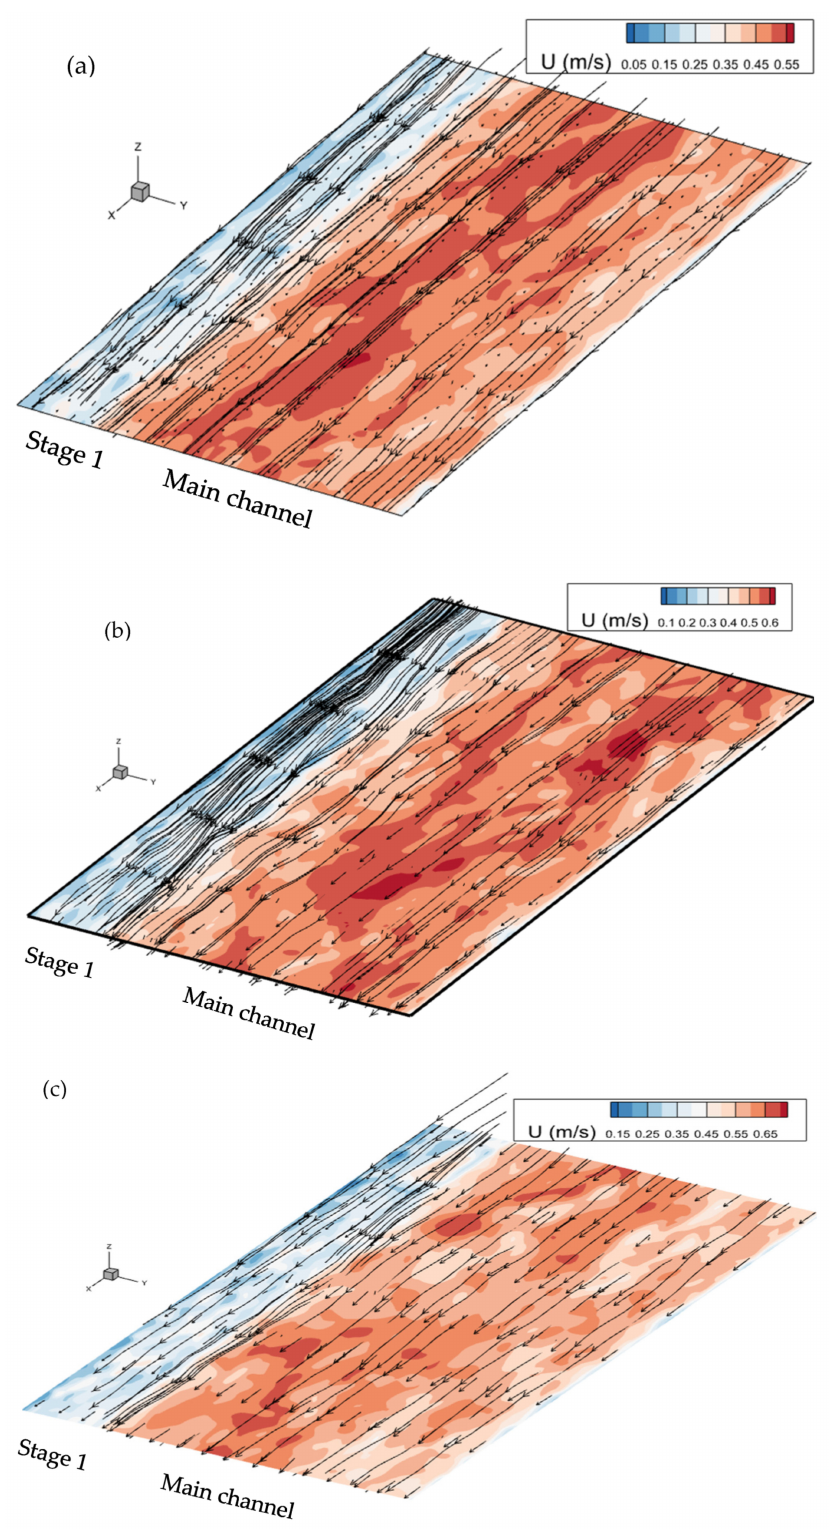
Figure 4. The distribution of the instantaneous streamwise velocity u and the velocity vectors ( u , w ) for ( a ) Dr = 0.1, ( b ) Dr = 0.3 and ( c ) Dr = 0.5 to illustrate the shear layer at a horizontal plane at the first stage Z = 0.04 m, for a constant time interval of 0.1 times of flow cycle. A factor of 10 for clarity increases the values of